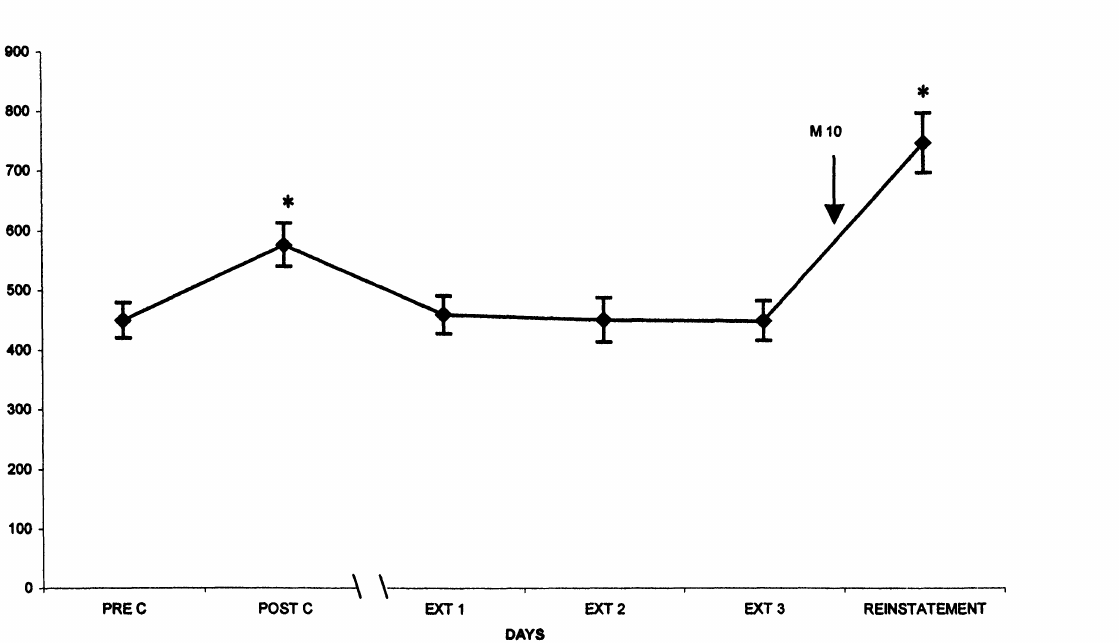
Fig. 3: (B) Effect of a priming dose of 10 mg/kg of morphine on reinstatement of a repeatedly extinguished morphine- induced CPP. Animals were conditioned with 40 mg/kg of morphine and acquire a clear CPP, reflected by the significant difference in the time spent in drug-paired compartment between pro-conditioning (PRE C) and post- conditioning (POST C). Mice then underwent several extinction sessions until the time spent in the drug-paired compartment was non significantly different to that spent in this compartment during PRE C (EXT 1). After two more consecutive extinction sessions (EXT 2 and EXT 3), animals received a priming dose of 10 mg/kg of morphine (M 10) and 30 min later were tested for their preference (REINSTATEMENT). * p < 0.01, significant difference in the time spent in pro-conditioning vs. post-conditioning sessions or reinstatement